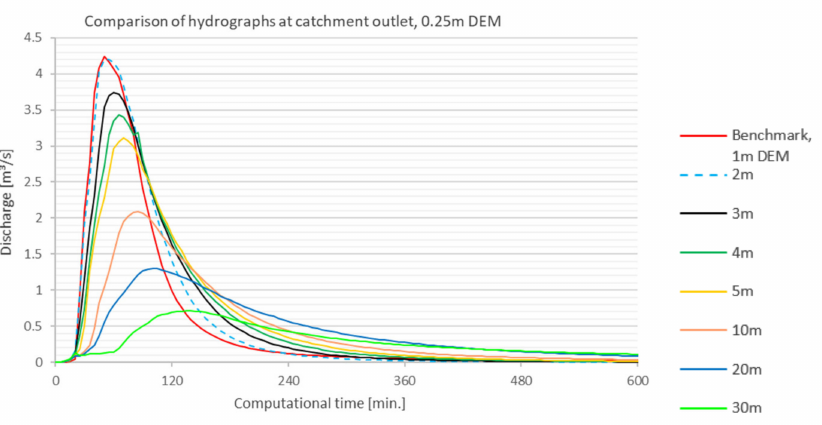
Figure 10. Overview of hydrographs at the outlet of the catchment for DEM 0.25 m and different mesh resolutions (mesh: colored